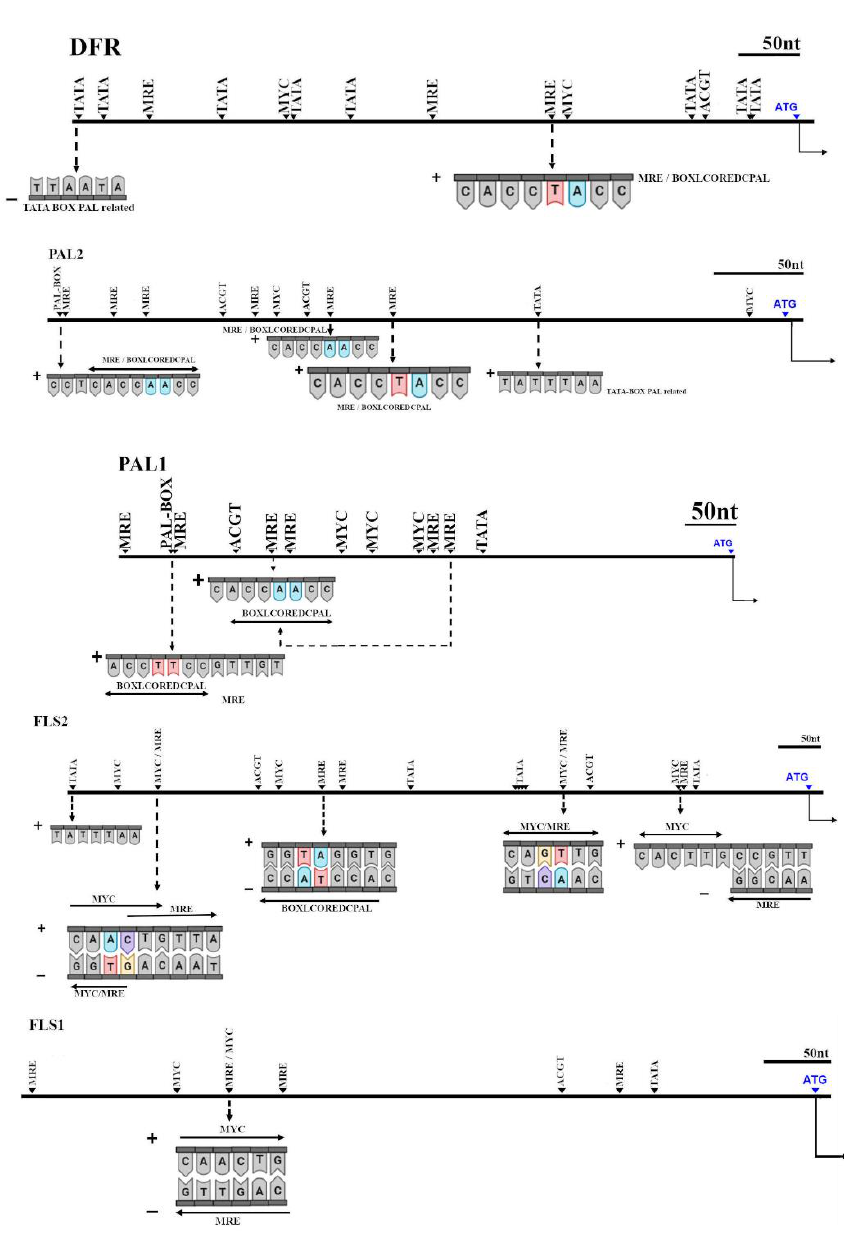
Figure 7. Analysis of cis-acting elements on 1500 bp upstream from start codon (ATG) sequences of Prunus armeniaca DFR , PAL , and FLS genes. MRE: MYB-like Recognition Element; MYC: MYC-like recognition sequence; TATA: TATA box-like; BOXLCOREDCPAL: Consensus of the putative “core” sequences of box-L-like PAL promoter region.